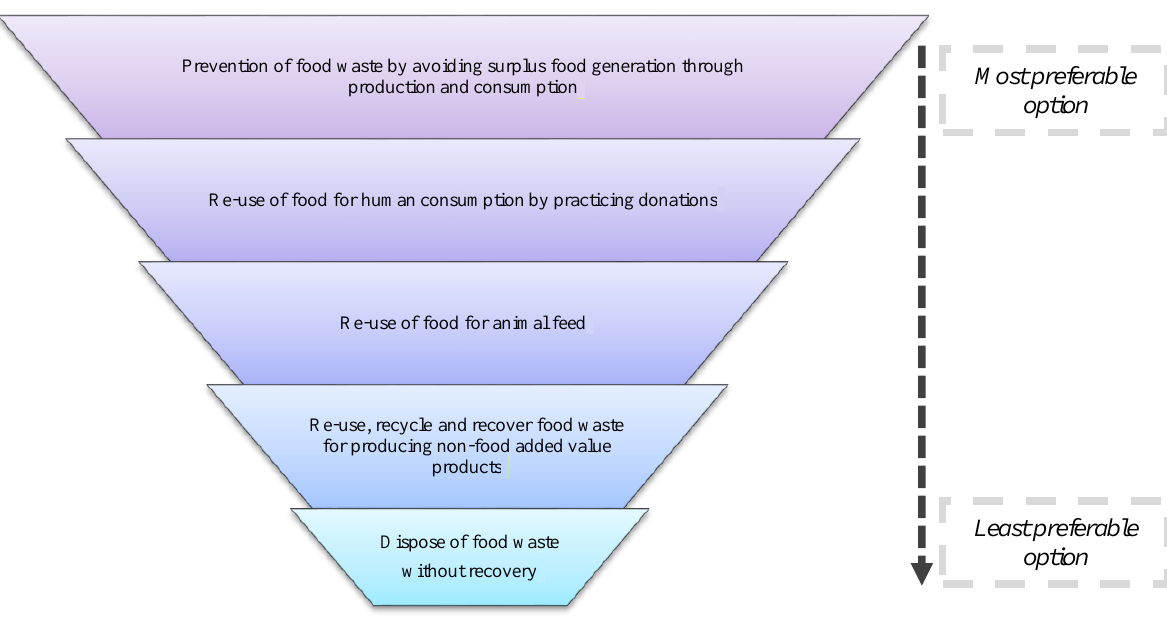
Figure 1. Enhancing environmentally friendly solutions for food waste management in the EU-Source: Illustration created